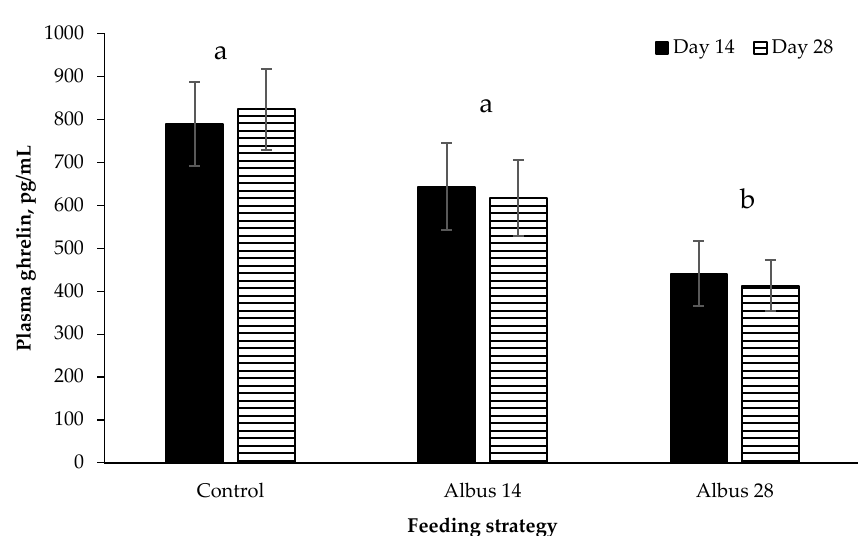
Figure 3. Plasma ghrelin concentration on day 14 and day 28 after the implementation of the experimental diets (mean ± SE; n = 24). There was a significant effect of diet ( p = 0.002). Data for entire males and IC males have been pooled as there was no effect of sex or any interactions ( p > 0.05). a,b Different superscripts between diets are significantly different.